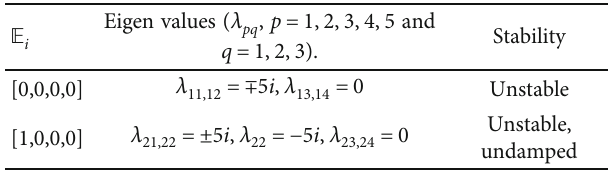
and (c) ϖ = 0 : 98 , Table 2: Linear stability analysis of system (2).